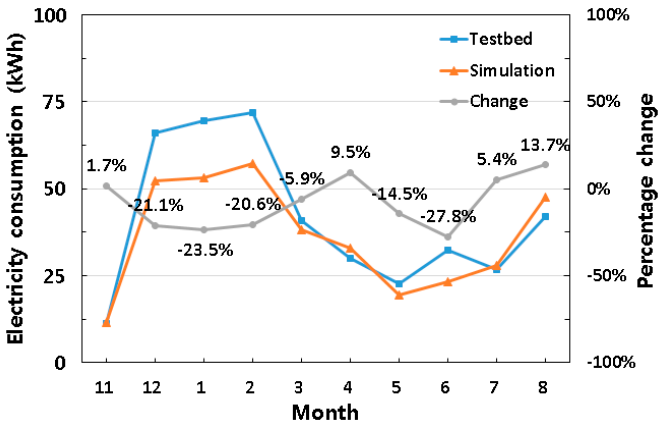
Figure 8. Case 1: Suwon weather data + single-speed operation heat pump. Table 10. Comparison of heat-pump power consumption (kWh) for cooling / heating of testbed and simulation.